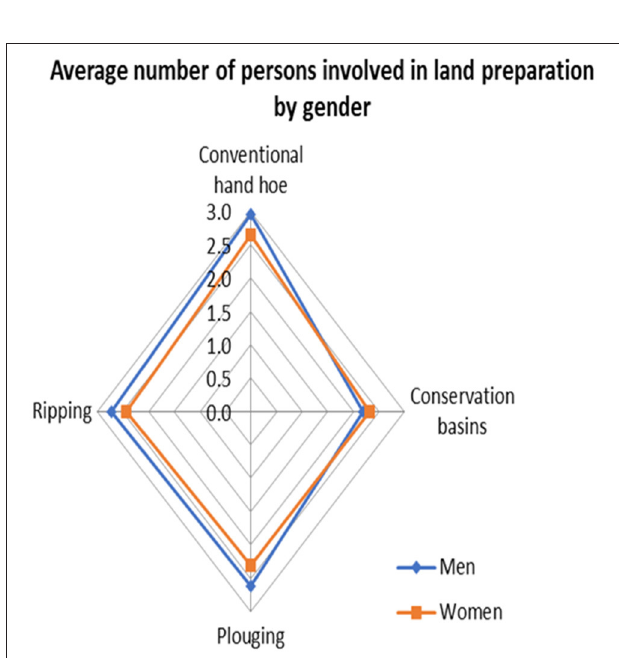
FIGURE 7 | Participation in tillage activities by men and